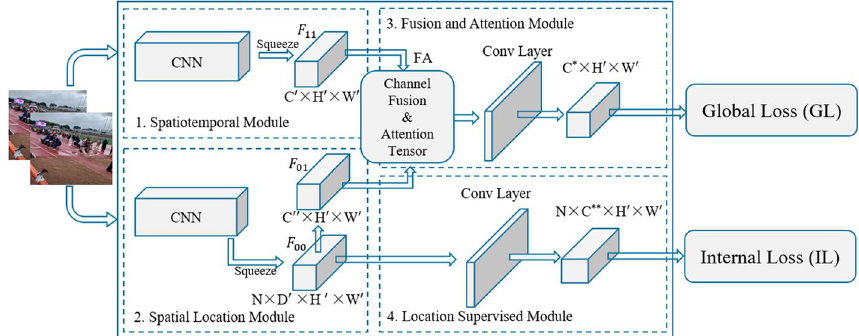
Fig. 3 Baseline framework. The internal loss function focuses on the loss between the network’s predicted location and the ground truth locations based on the video